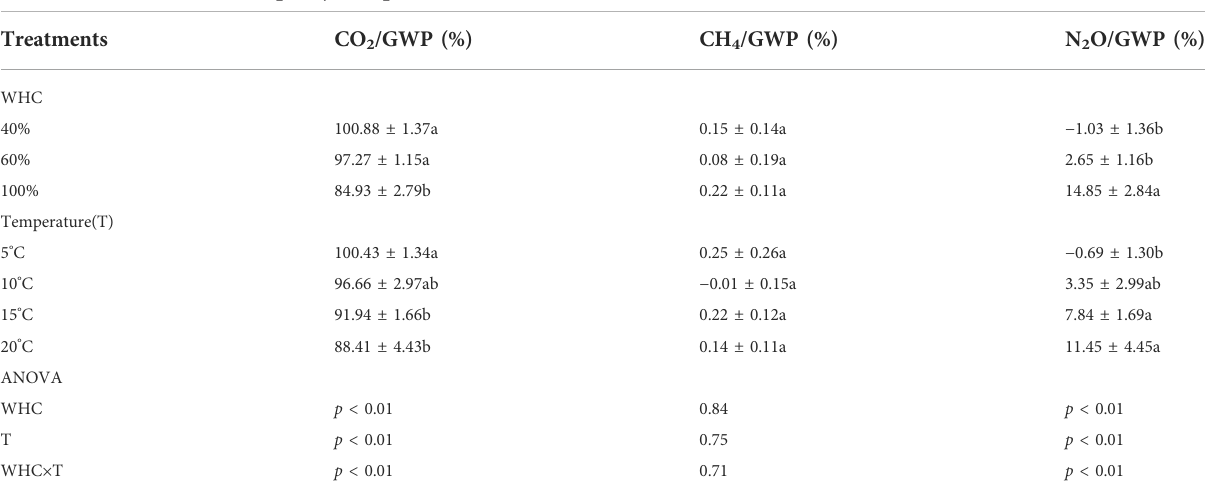
TABLE 2 The contributions of CO 2 , CH 4 and N 2 O emissions to